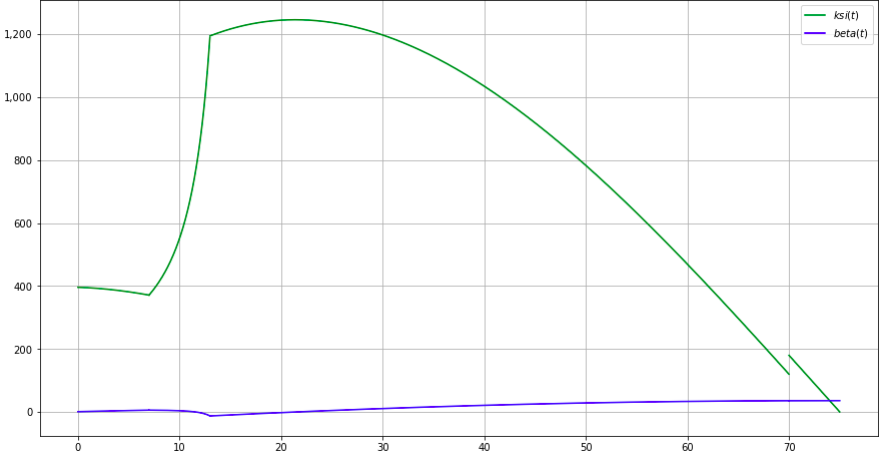
Figure 2. The imputation for the player (green) and the imputation distribution procedure (IDP)